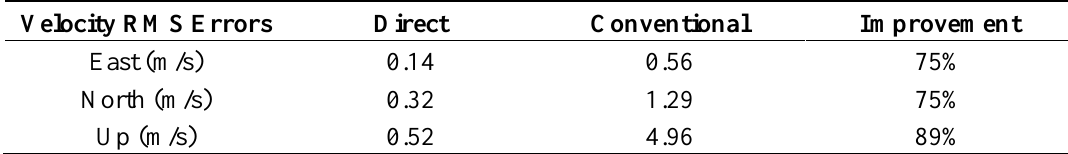
Table 1. Velocity RMS errors–indoor scenario